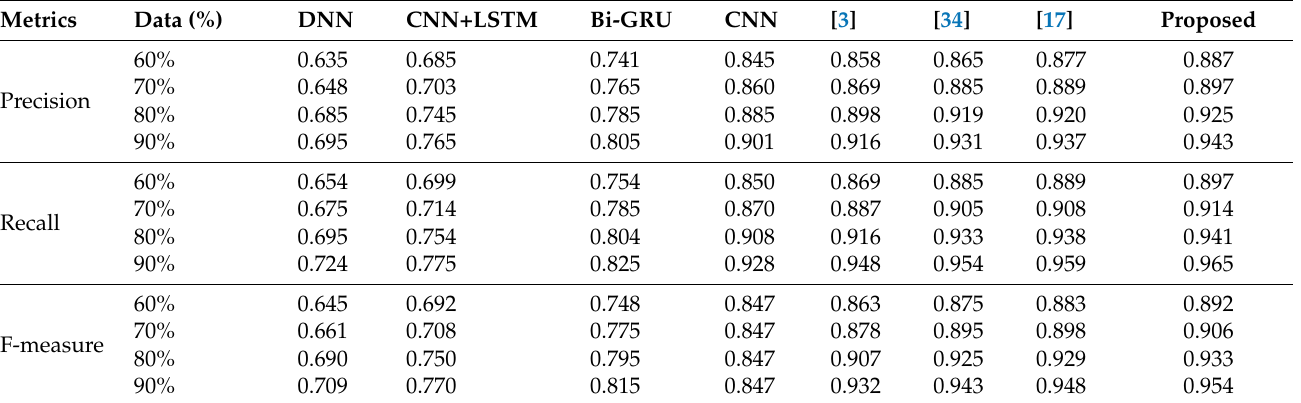
Table 5. Comparative analysis of Review Rating Prediction for IMDB dataset in terms of precision, recall and F-measure.